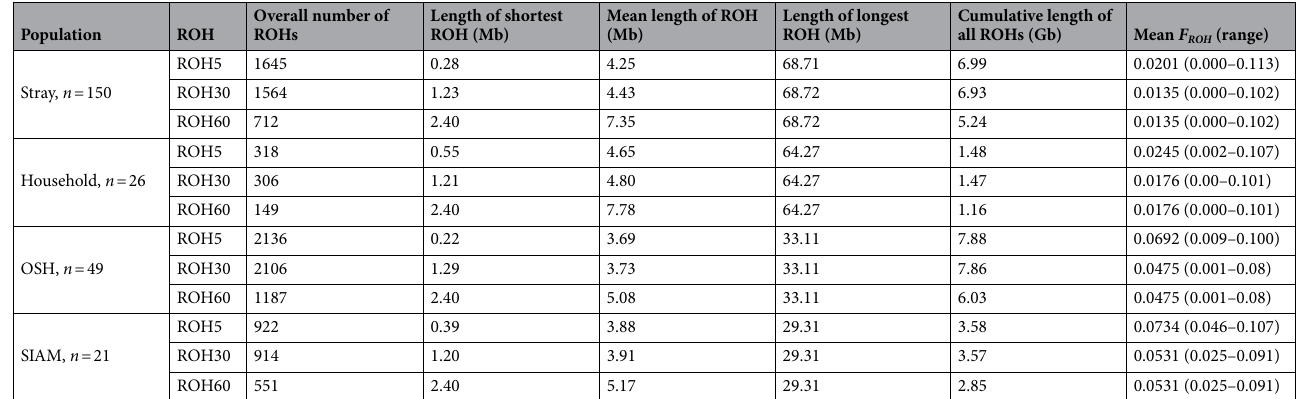
Table 2. Individual patterns of runs of homozygosity (ROHs) for the four cat populations. ROH5, ROH30 and ROH60 comprised windows of at least 5, 30 and 60 SNPs, respectively. For all three different classifications of ROHs, number and length of detected ROHs and the inbreeding coefficient F ROH for each of the four populations are given. In total, the genotyped single nucleotide polymorphisms (SNPs) covered 2,322,306,946 bp of the autosomal cat genome.